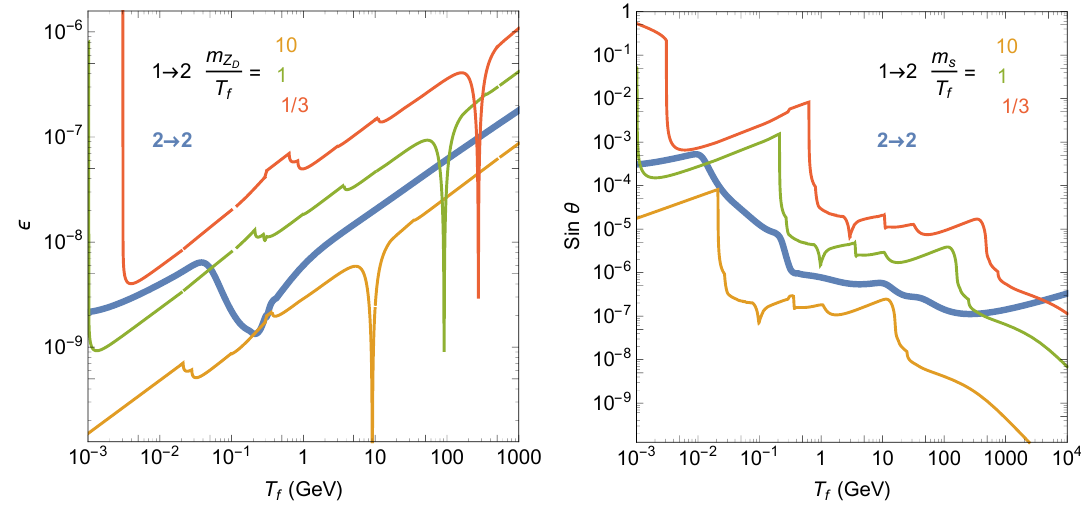
Figure 13 . Comparison of the minimum allowed value for the portal coupling for only the 2 $ 2 processes and only the 1 $ 2 process for (cid:12)xed values of m (cid:30) =T f . Left: the HSFO-VP model for three . T choices of m Z =T f where m (cid:31) =T f (cid:24) 20. For m Z f , 1 $ 2 processes are unimportant except at D D very small masses and for m Z (cid:24) m Z . For m Z (cid:29) T f , 1 $ 2 processes can dominate everywhere. D D Right: as left (cid:12)gure, but for the HSFO-HP model. Here when m s . T f , 1 $ 2 processes